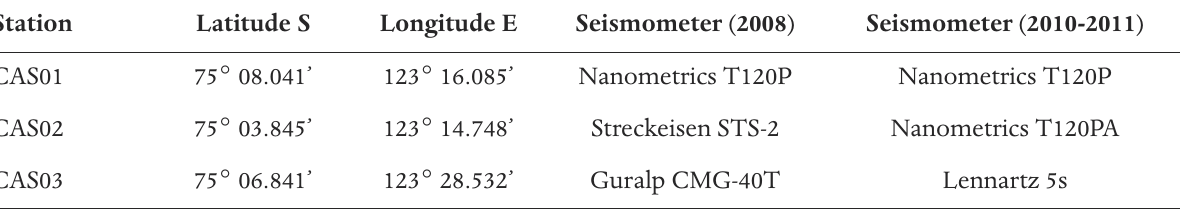
Table 1. Prototype CASE station locations and seismometer